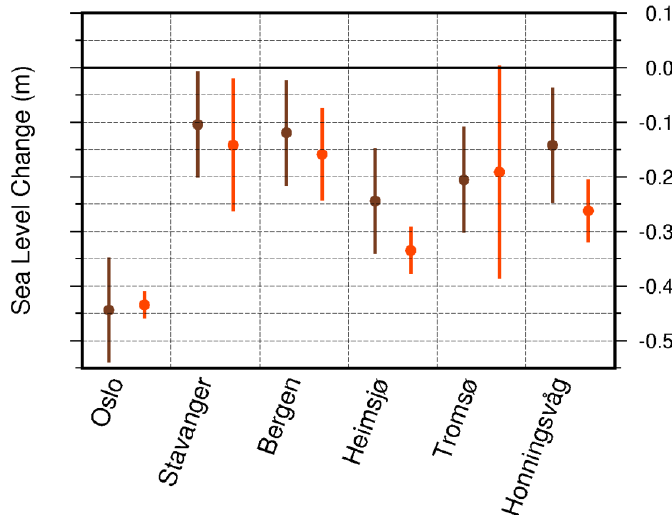
Figure 7. Regional relative sea-level change (m) due to GIA and associated gravitational effects over the period 1986–2005 to 2081–2100 for our GIA solution (brown) and IPCC AR5 (red). Dots show mean values and vertical bars the 5% to 95% uncertainty.